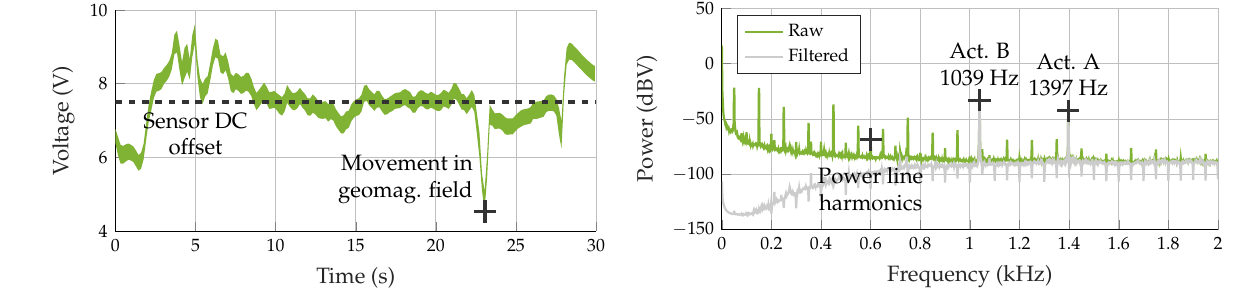
( b ) Power spectral density of raw and pre-filtered signals.